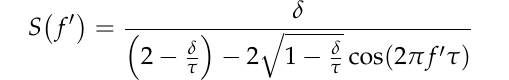
Figure 9. Phase noise in OEO with narrowband demodulation as a function of the frequency offset at different generation frequencies: curve 1–4, 2–6, 3–8, 4–10, and 5–12 GHz.